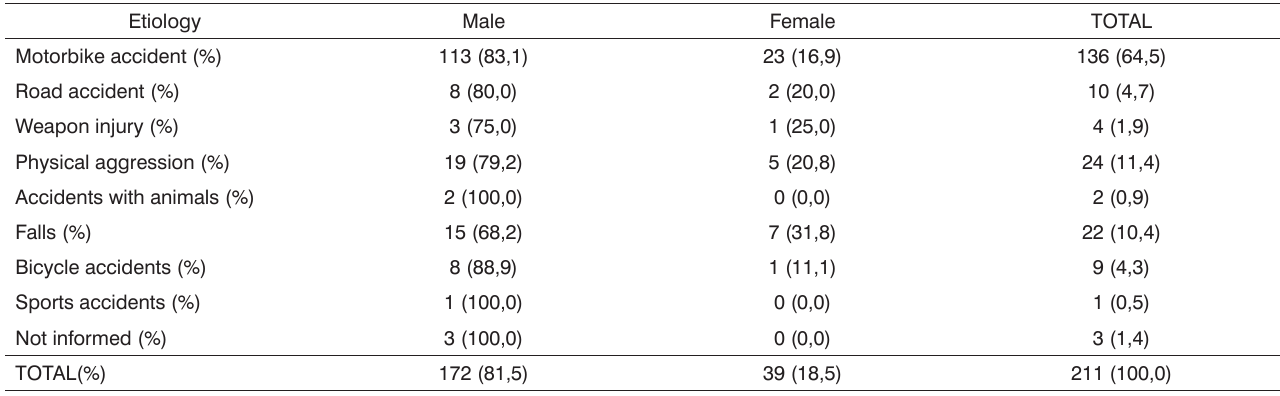
Table 4. Distribution of the sample per etiology and gender of patients.